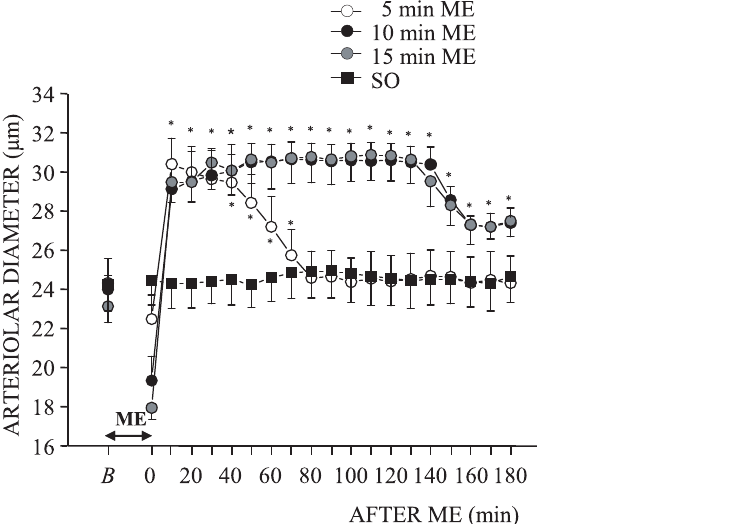
Fig. 3. ME of different durations caused a biphasic response in order 2 pial arterioles. The values of the diameters of order 2 arterioles have been measured before and after ME. ME of different durations induced a simultaneous vasoconstriction followed by a vasodilation persisting for 70 minutes after 5 minutes ME (open circle) and for the whole after ME observation period (180 minutes) after 10 (filled circle) or 15 (grey circle) minutes ME. No changes in diameter values have been detected in SO rats, (filled square). * Significantly different from the baseline